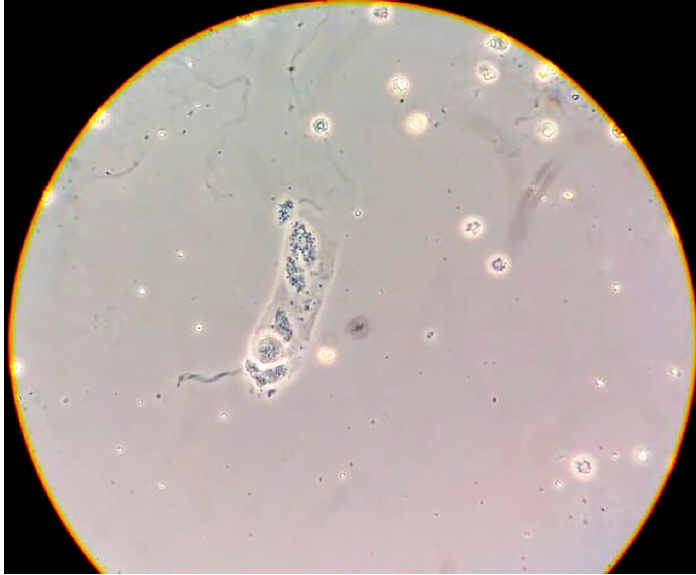
Figure 2. Urinary sediment with dysmorphic erythrocytes and a small granular cast.